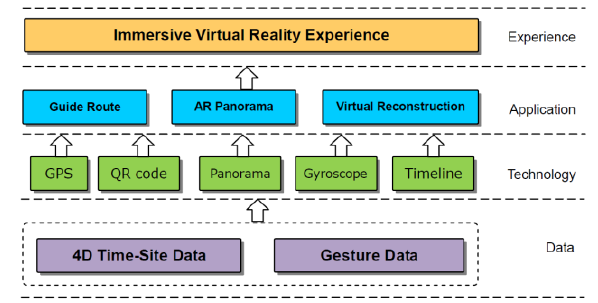
Figure 3. VR Generation Structure and Strata